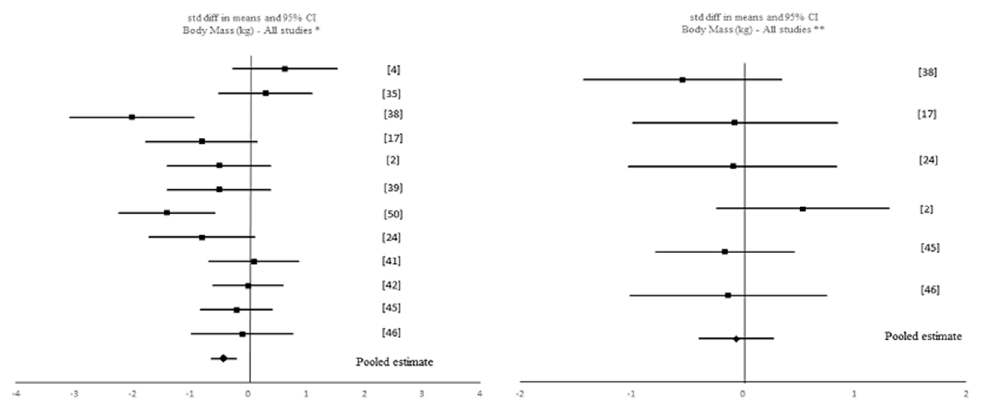
Figure 5. Forest plot of the effects from a random-effects meta-analysis shown as standardized mean difference with 95% confidence intervals on body mass for all studies. For each study, the square represents the standardized mean difference between pre- and post-intervention time points and, whenever possible, between pre-post data of both intervention and control groups with the horizontal line intersecting it as the lower and upper limits of the 95% confidence interval. The rhombi represents the pooled estimated standardized mean difference. Note. * Pre- post tests, IF intervention; ** Pre-post tests, IF intervention vs. control.